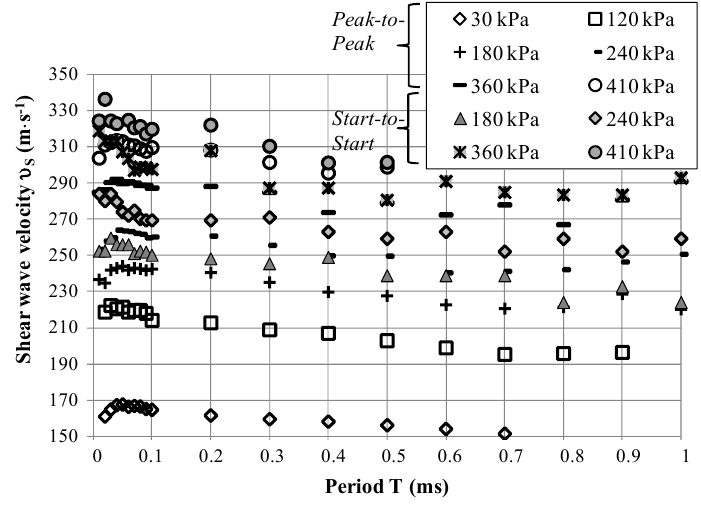
Figure 16. Comparison of υ S obtained using various methods of travel time determination.